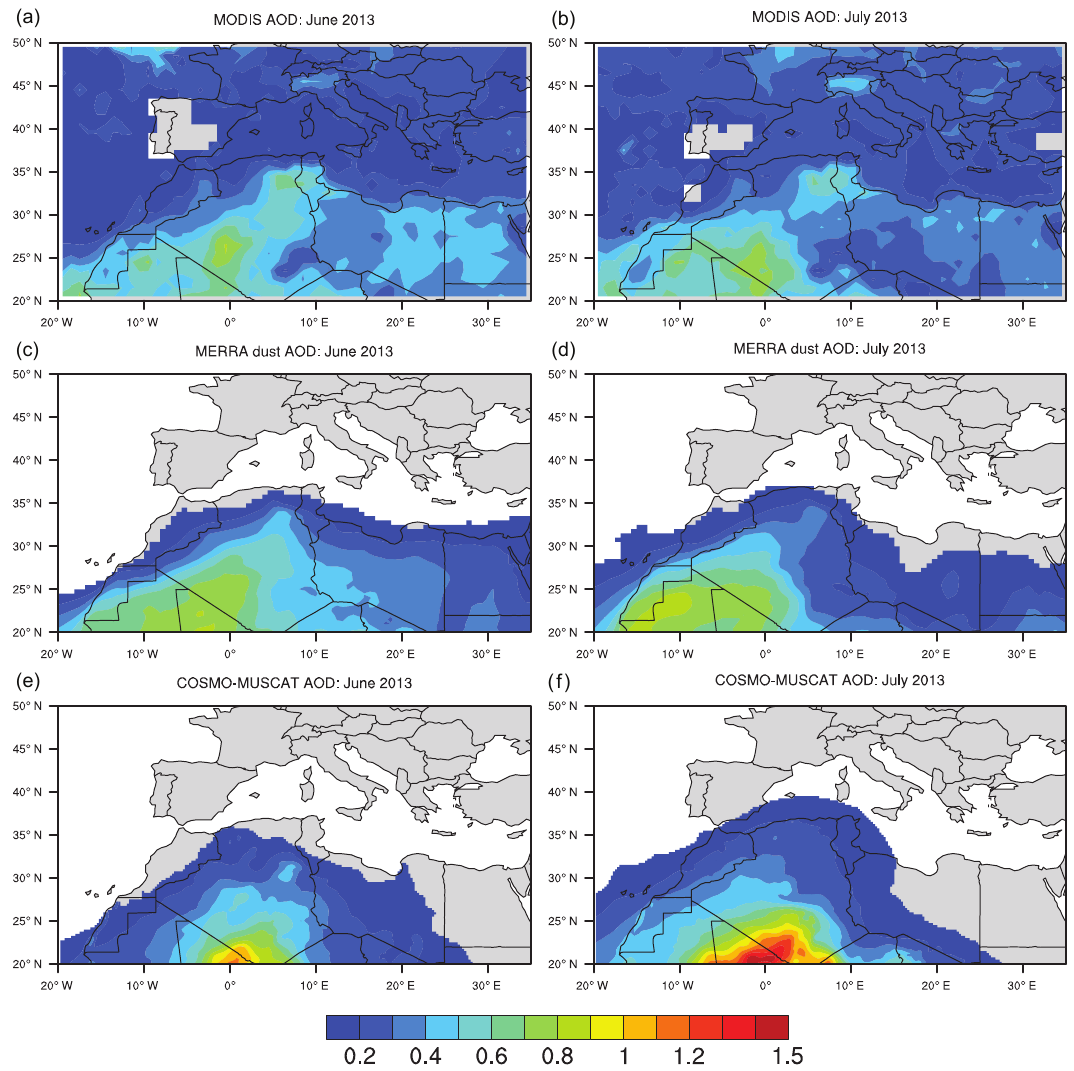
Figure 3. Spatial distribution of dust AODs over north Africa and the Mediterranean basin shown as monthly mean values. Upper panel shows the monthly mean AOD distribution as estimated from Terra and Aqua MODIS observations (MODIS Collection 6 merged aerosol product) for June (a) and July (b) 2013. Middle panel shows June (c) and July (d) mean dust AOD taken from the MERRA data set for 2013. Bottom panel shows monthly mean dust AOD distribution as estimated from COSMO-MUSCAT 12:00UTC simulations for June (e) and July (f) 2013. Please note that the MODIS AOD includes all aerosol types, whereas MERRA and COSMO-MUSCAT AODs represent the atmospheric dust load